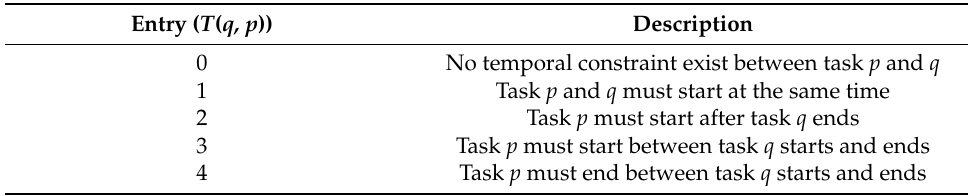
Table 10. Entry for temporal constraint matrix in centralized